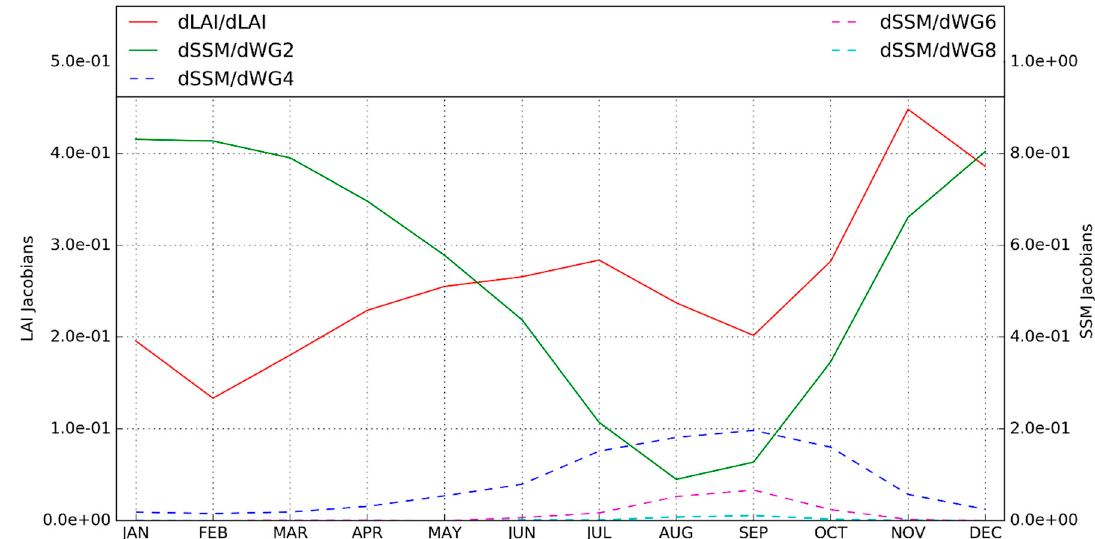
Figure 6. Seasonal evolution of LDAS-ERA5 Jacobians averaged over January 2001 to June 2018, δ LAI (red solid line), δ SSM (green solid line), δ SSM (blue dashed line), δ SSM (purple dashed line), and δ SSM δ LAI δ w 4 δ w 6 (cyan dashed line) are presented.